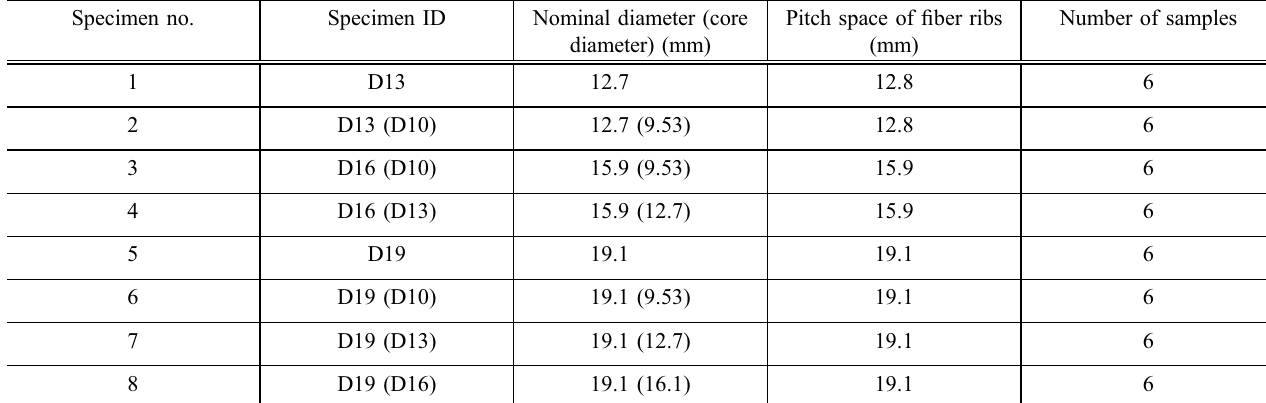
Fig. 2 Pultrusion and thermosetting process of sand coated GFRP and deformed steel hybrid bar. Table 1 Details of the GFRP hybrid bar.